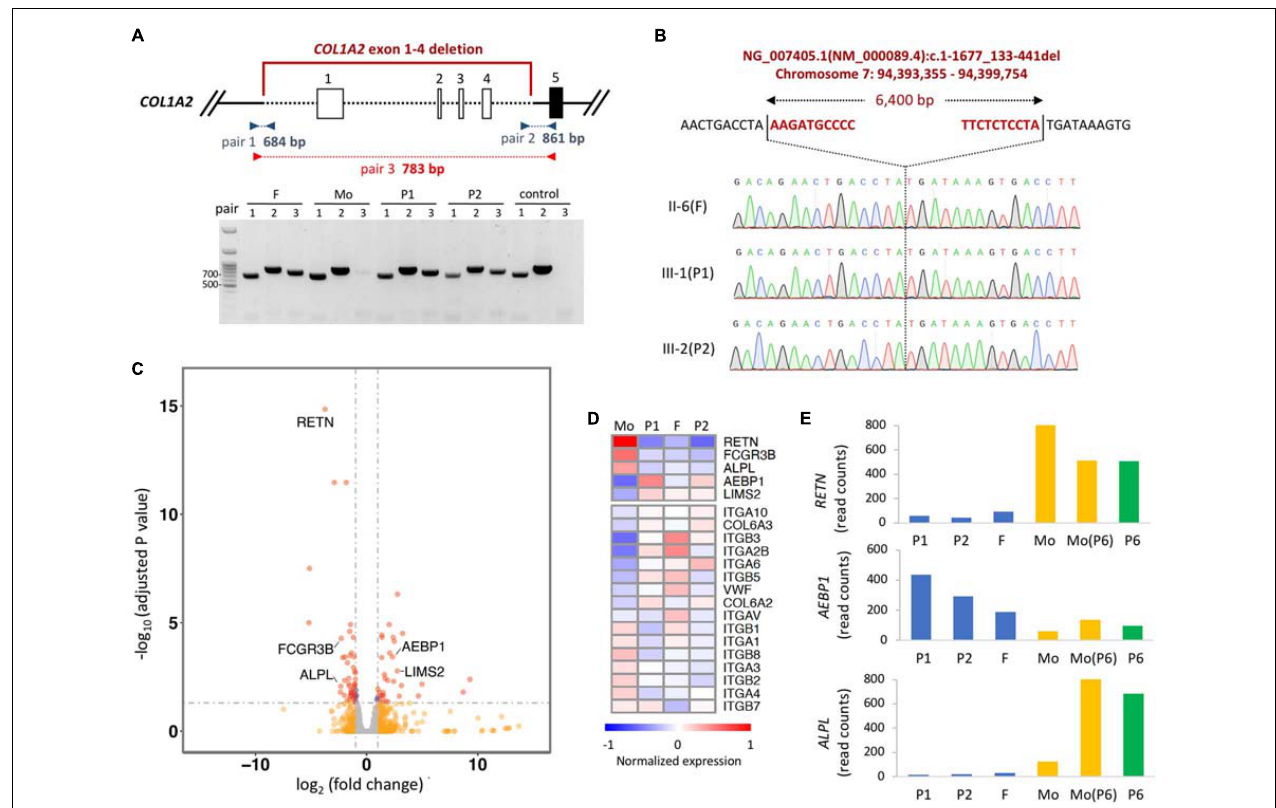
FIGURE 2 | Detecting the breakpoint of heterozygous deletion in COL1A2 . (A) Schematic representation of the deletion region of exon 1–4. Boxes represent exons, and dashed lined represent deleted regions. PCR amplicons used to validate the deletion with three set of primers are shown. Red primers only amplified the deleted region. (B) Identification of breakpoint of COL1A2 by Sanger-sequencing the product amplified with red primers shown in (A) . The upper sequences show the non-deleted DNA reference sequence, while the lower sequence shows the read-out from Sanger sequencing with the breakpoint location. (C) Volcano plot showing differentially expressed gene in PBMCs when comparing samples with COL1A2 deletion (P1, P2, and father) vs. control (mother of P1 and P2). Red dots, genes with adjusted P -value < 0.05 and log 2 fold change > 1 ( n = 37) or < –1 ( n = 48); blue dots, adjusted P -value < 0.05; orange dots: log 2 fold change > 1 or < –1; gray dots, none of the above. (D) Heatmap showing DEseq2 normalized expression of genes differentially expressed when comparing P1, P2, and F vs. Mo. Mo, mother of P1 and P2; F, father of P1 and P2. (E) DEseq2 normalized read counts of genes in two families. Mo, mother of P1 and P2; F, father of P1 and P2; Mo (P6), mother of